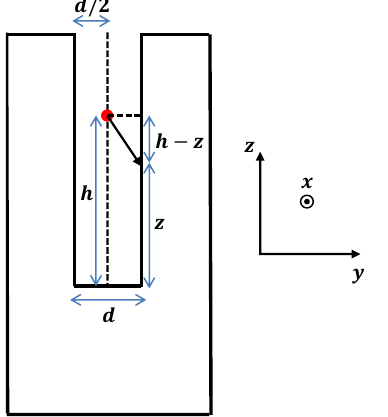
Figure 7. QTF with the main parameters employed for calculations and related to the coordinate system used. The origin of the y-axis is centered between the prongs.